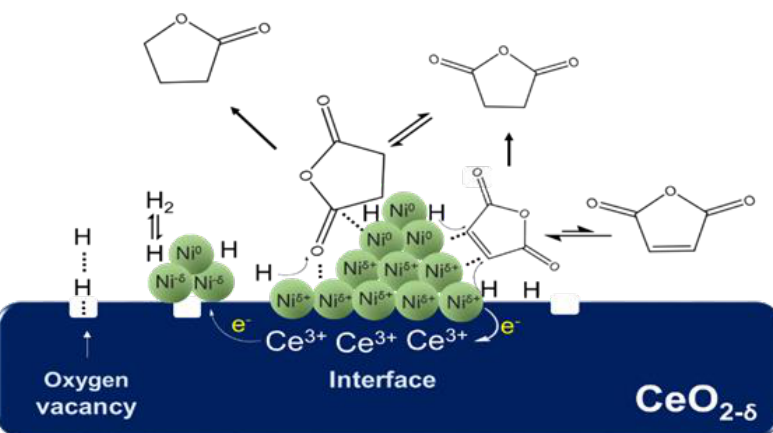
Figure 15. The synergy of Ni δ+ – Ni 0 in C=O hydrogenolysis over Ni/CeO 2 catalyst.